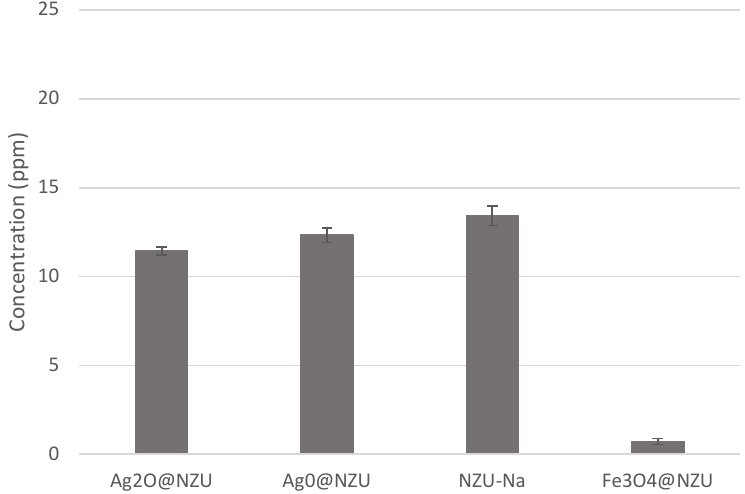
Figure 9. Discoloration of MB solutions by the modified zeolites (H 2 O 2 concentration: 42.4 mM).